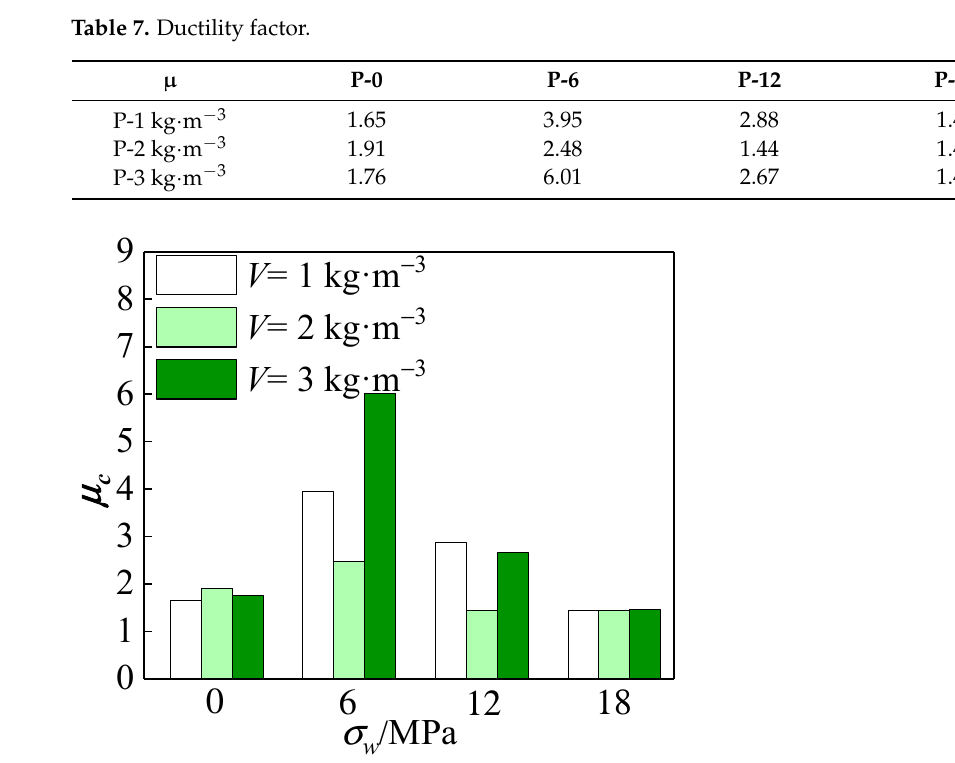
Figure 26. Relationship between ductility coefficient and confining pressure value. Table 7. Ductility factor.